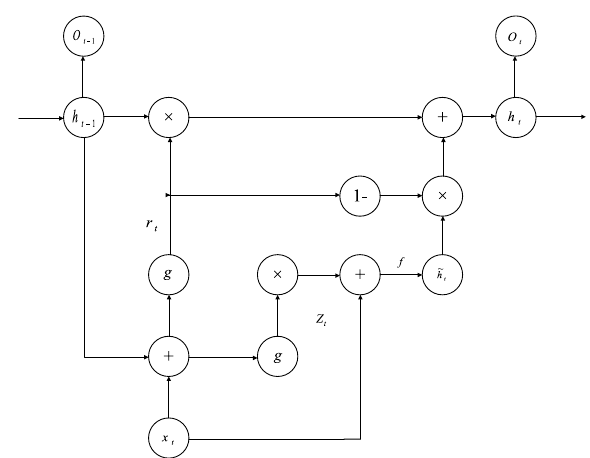
Fig. 6 Structure diagram of GRU hidden